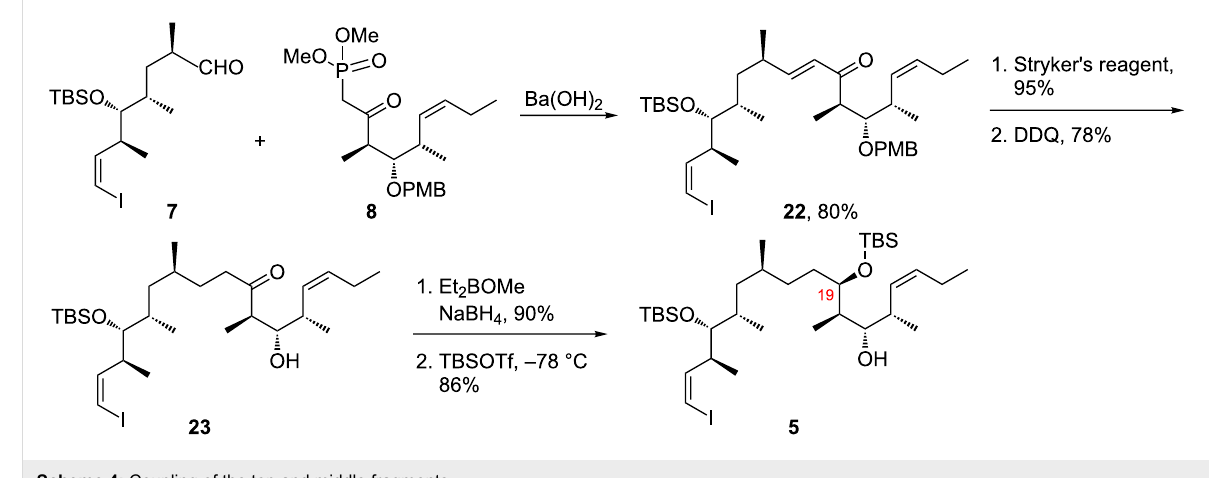
Scheme 4: Coupling of the top and middle fragments.